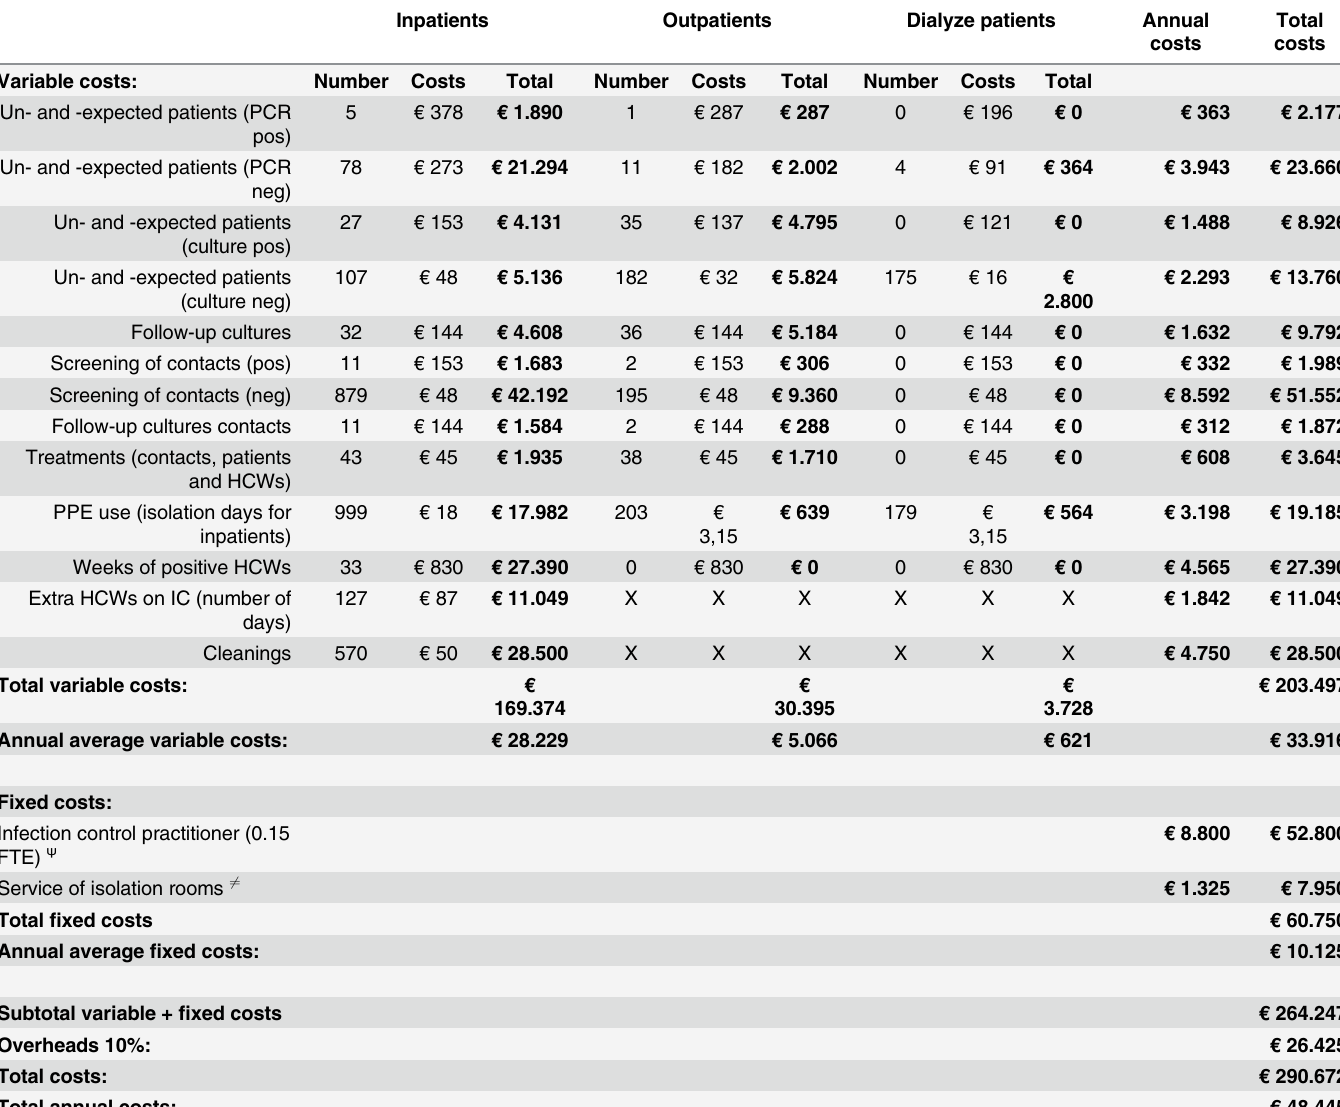
Table 4. Costs of the MRSA Search and Destroy policy between 2008 and